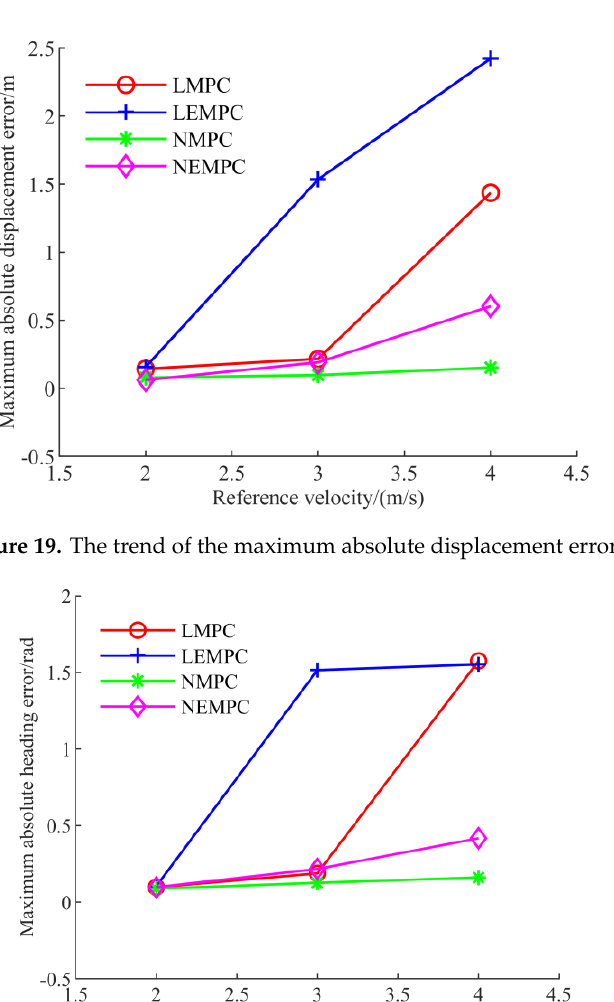
Table 5. Changed parameters in controllers.